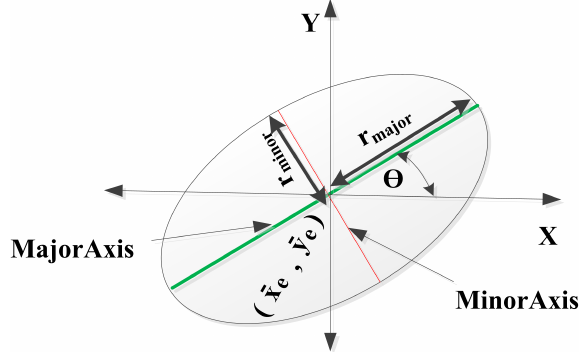
Figure 4. Ellipse with